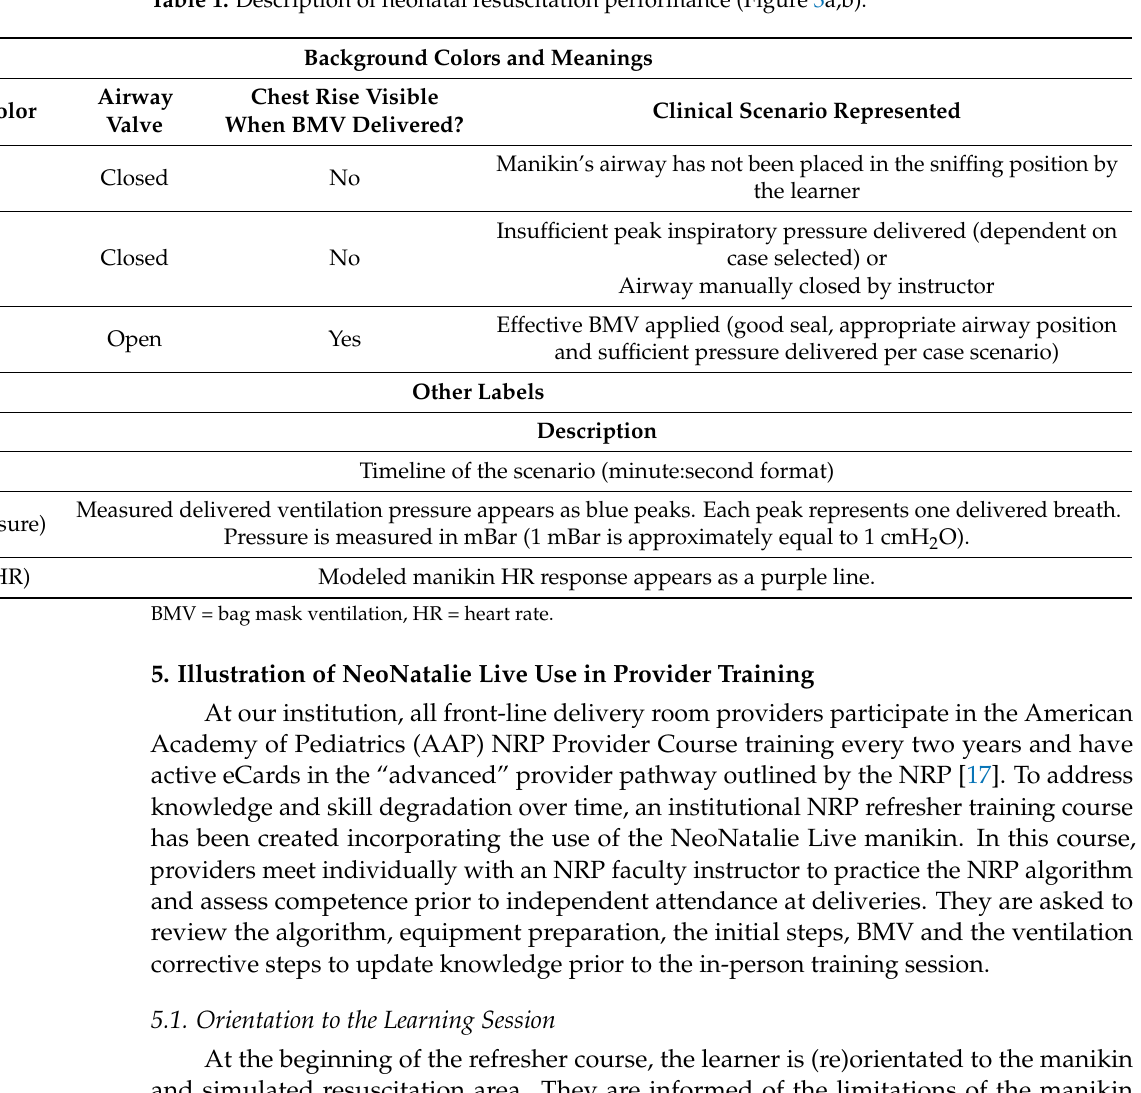
Table 1. Description of neonatal resuscitation performance (Figure